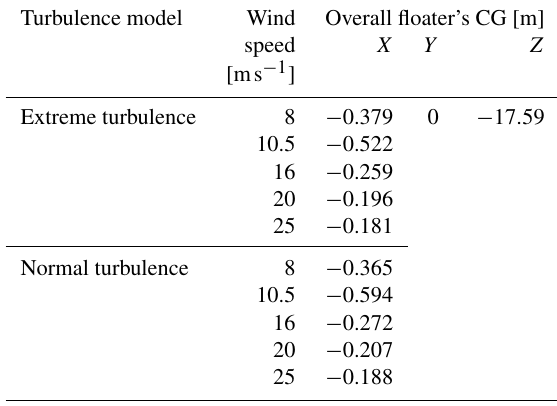
Table 6. Activefloat active ballast schedule.